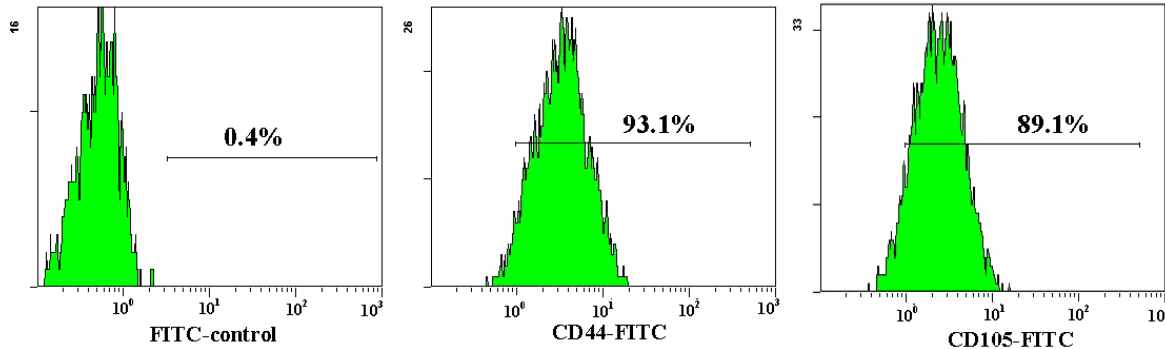
Figure 5. Flow cytometric analysis of AD-MSCs surface antigen. The cell surface